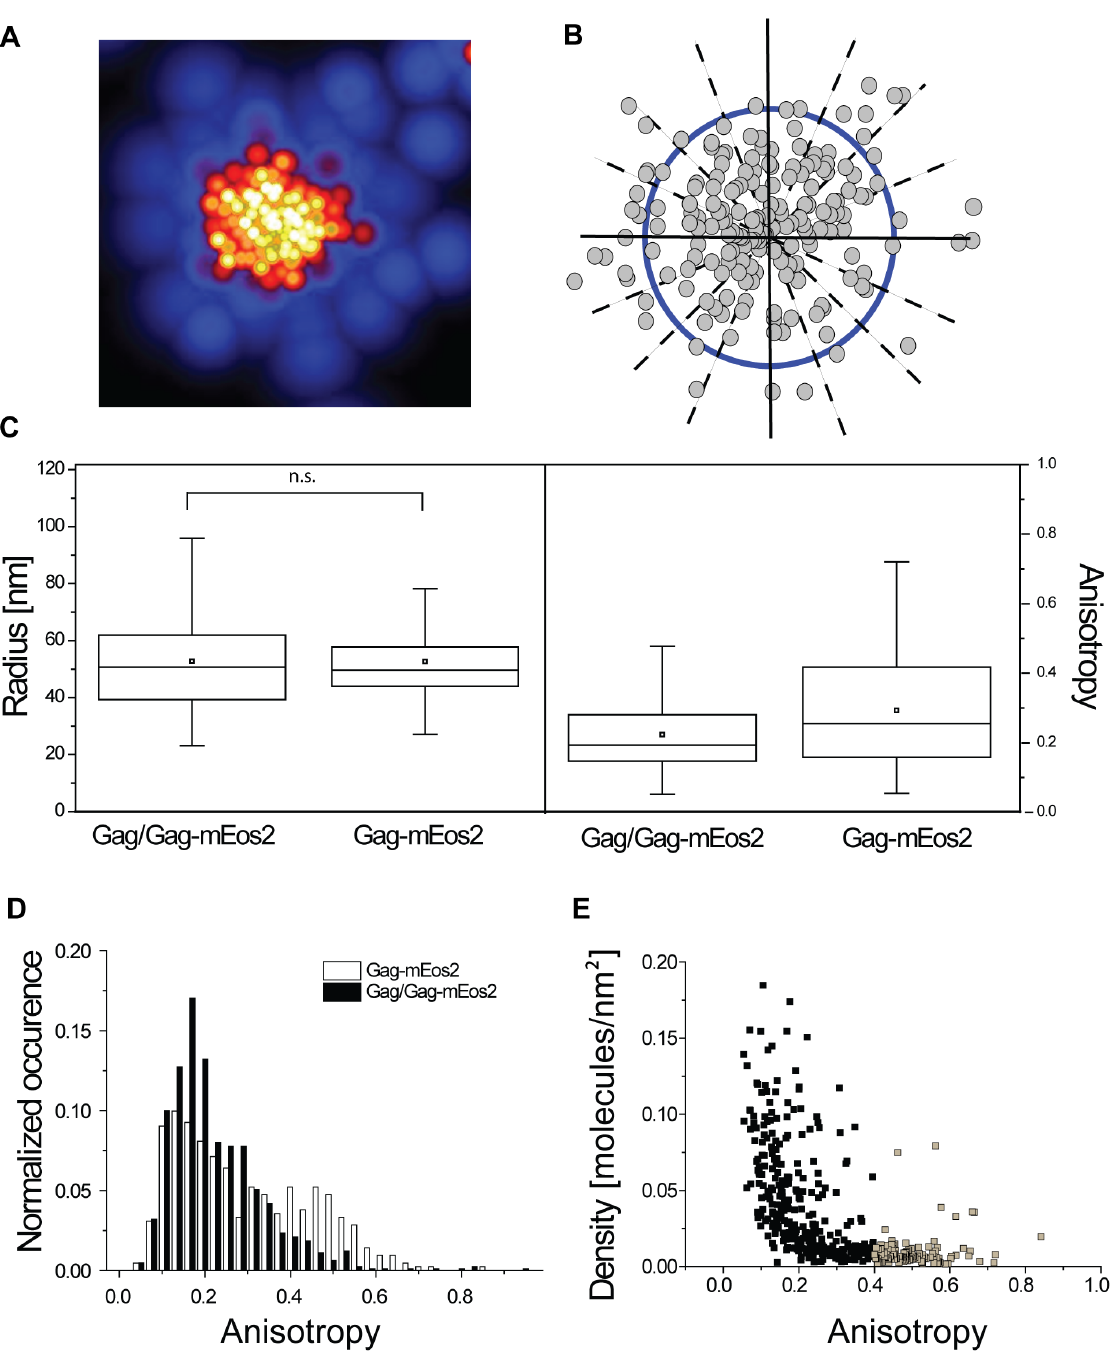
Figure 6. Quantification of the morphology of unlabeled and monomerically labeled Gag. ( A ) PALM image of VLP formed from Gag-mEos2 only. ( B ) Schematic illustration of computation of mean radius (blue circle) and radial anisotropy calculated from radial sectors (dashed lines). ( C ) Radius and radial anisotropy, defined as the coefficient of variation of the radius over all 16 sectors, for cells expressing Gag-mEos2 only or Gag and Gag-mEos2. Dots indicate mean, horizontal line within the box median, boxes indicate 25 th and 75 th percentiles and vertical bars 5 th and 95 th percentiles. ( D ) Normalized distribution of radial anisotropy (N . 400). ( E ) Density of Gag clusters for cells expressing Gag-mEos2 only as a function of the radial anisotropy. Clusters with high anisotropies (gray squares) tend to display low densities.